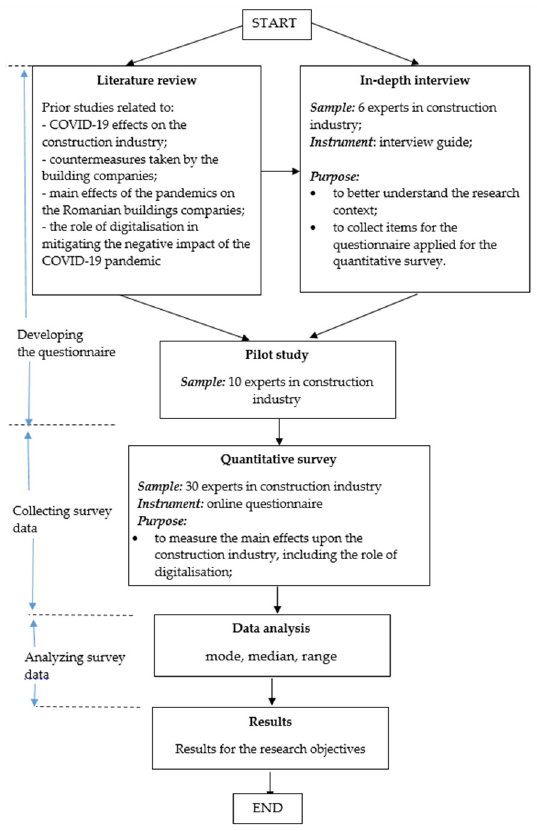
Figure 1. Research design.